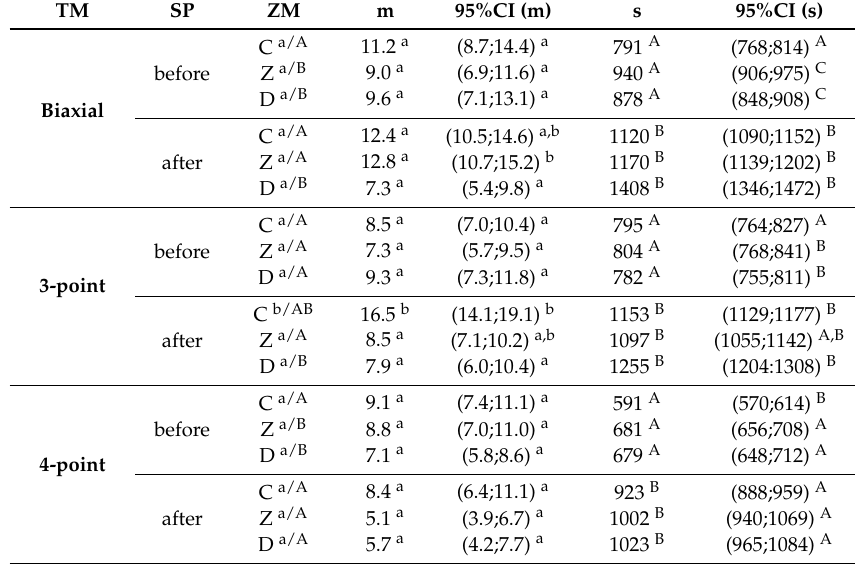
Table 6. Weibull statistics for flexural strength values of all measured groups. TM: test method; SP: specimen preparation; ZM: zirconia material; m: Weibull modulus; 95% CI: 95% confidence interval; s: characteristical strength. All values are presented in